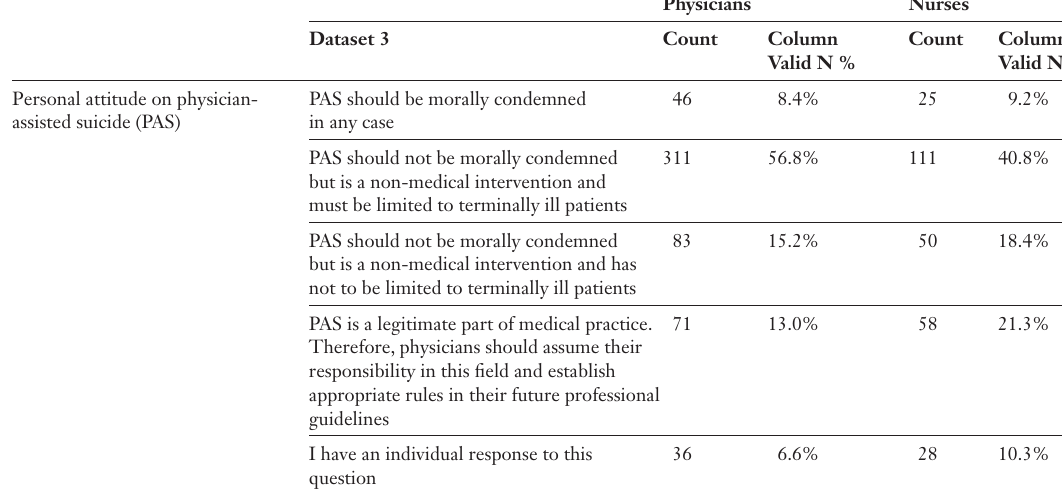
Attitudes towards physician-assisted